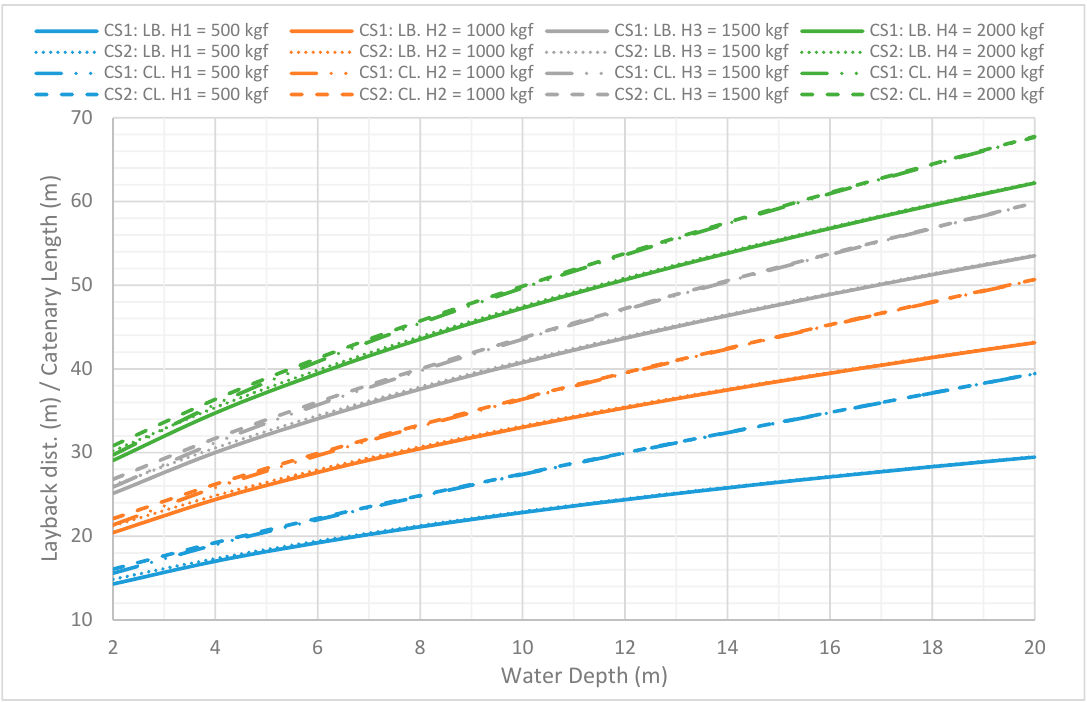
Figure 10. Layback distance (LB) and catenary length (CL) assuming CS1 & CS2 using different bottom tensions (500 kgf–2000 kgf) and water depths (2 m–20 m).